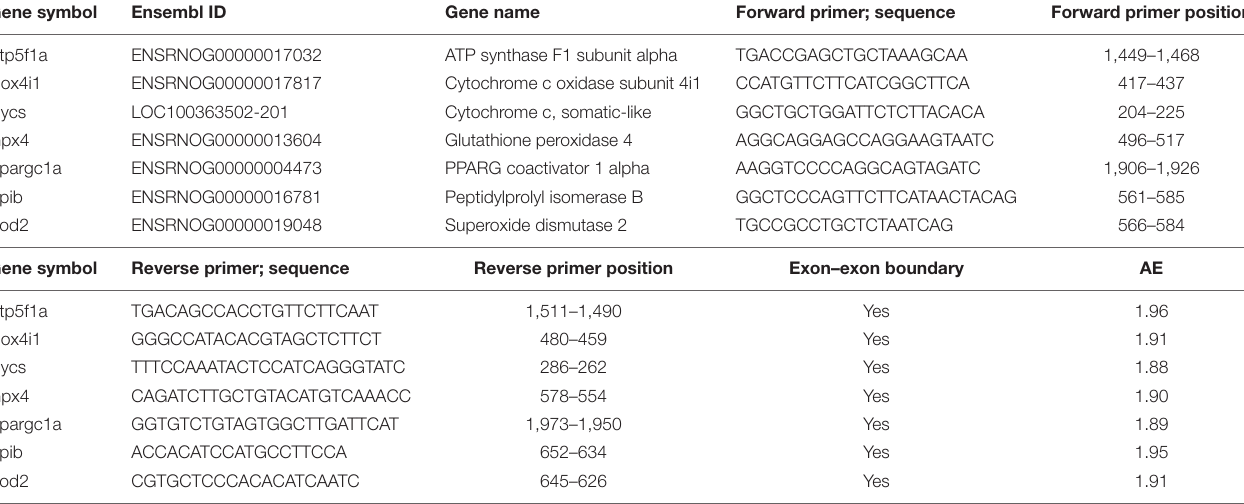
TABLE 2 | Genes investigated in this study: primer location, sequences, and amplification